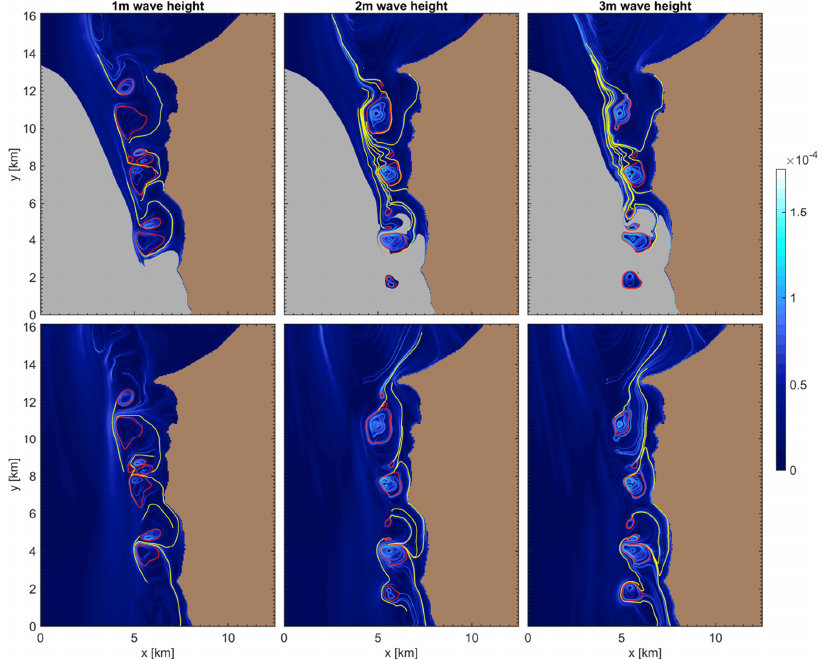
Figure A1. Sensitivity of LCS to wave forcing conditions. The ( top ) forward and ( bottom ) backward FLTE fields for a southward offshore current and 1m ( left ), 2 m ( center ) and 3 m ( right ) offshore wave heights. Plotted are the hyperbolic (yellow) and elliptic (red) LCS; the hyperbolic are either ( top ) repelling LCS at the initial time t 0 or ( bottom ) the attracting LCSs at the final time t 1 , while the elliptic LCS mark the boundaries of Lagrangian eddies at both initial and final times.